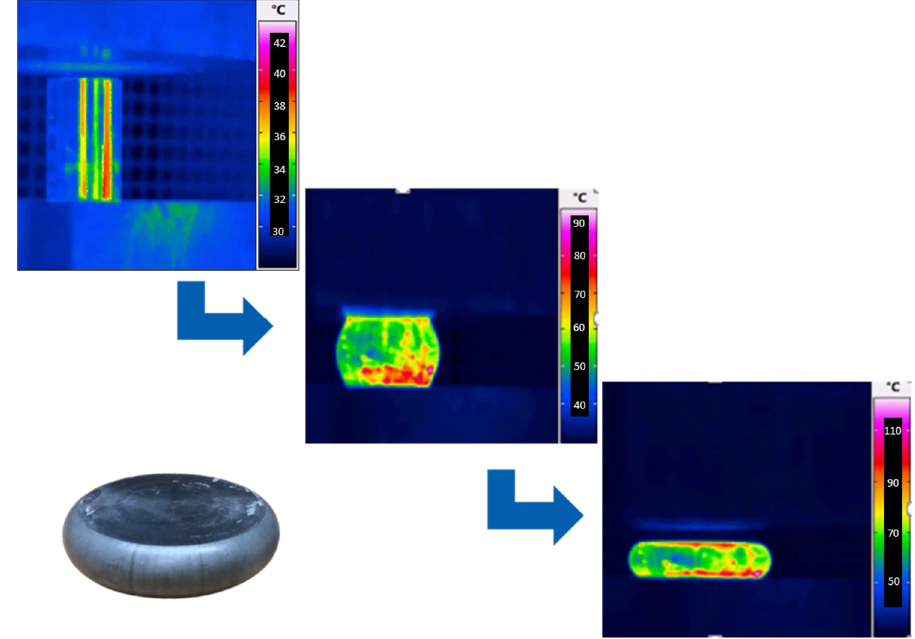
Figure 4. Upsetting process of ZEP1510 with IR camera, start temperature: 30 °C. In the case of CuZn39Pb3, the upsetting temperature was reduced step by step from 750 °C onwards. During the upsetting tests with an initial temperature of 450 °C, cracks appeared that can be clearly seen with the IR camera (see Figure 5).